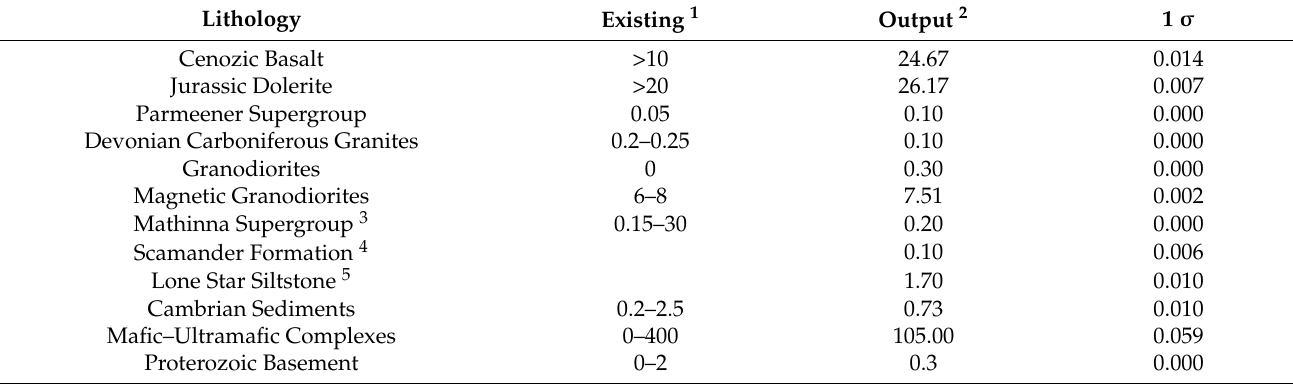
Table 4. Eastern Terrane existing and model-informed mean susceptibility (SI × 10 − 3 ).